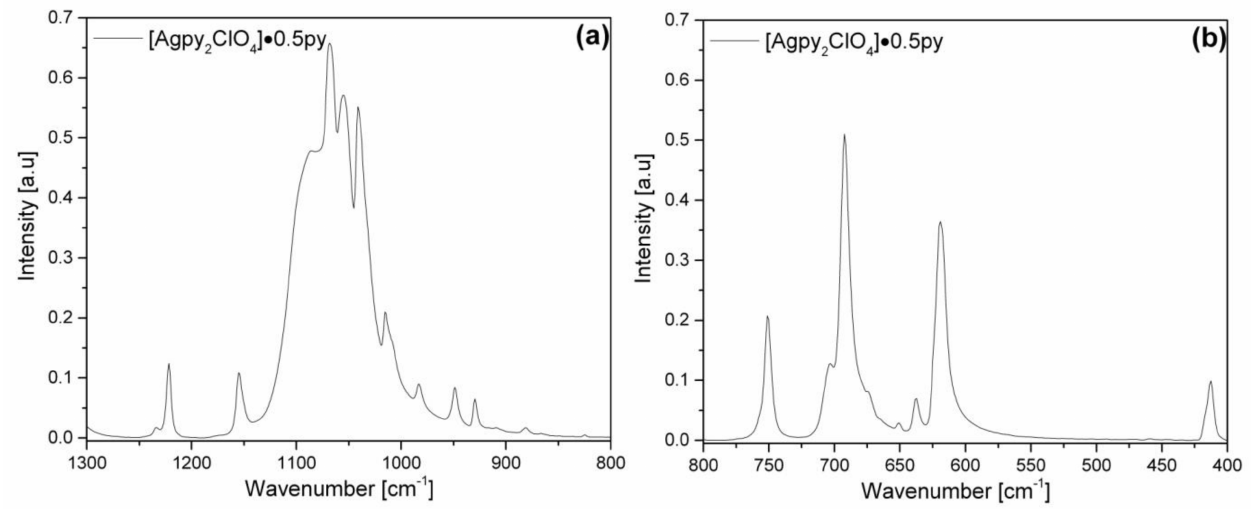
Figure 9. IR spectra of compound 1 at room temperature between 1300 and 800 cm − 1 ( a ) and 800 and 400 cm − 1 ( b